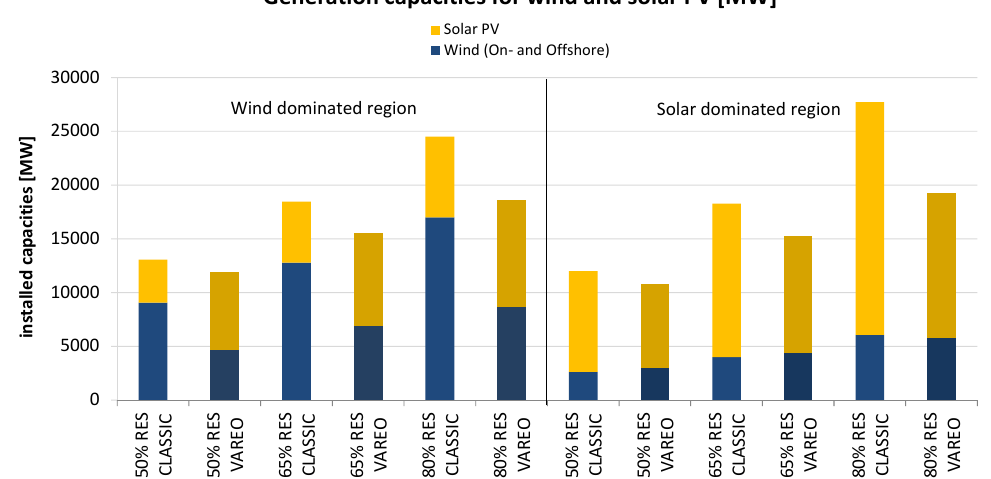
Figure 5. Wind and solar PV generation capacities for the six scenarios in the wind-dominated region (left-hand side) and the six scenarios in the solar PV-dominated region (right-hand side).